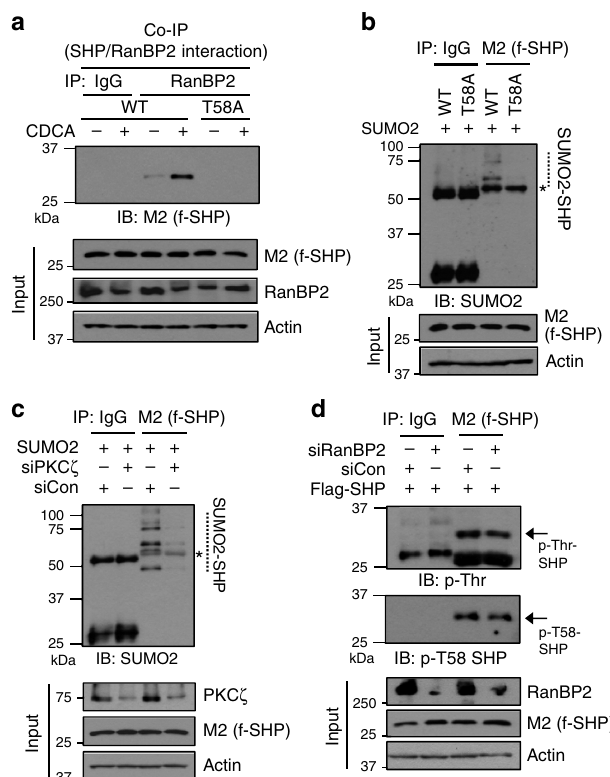
Figure 5 | Phosphorylation of SHP at Thr-58 is likely important for RanBP2-mediated SUMOylation of SHP. HepG2 cells were transfected with expression plasmids or siRNA for RanBP2 or PKC z as indicated, and then, the cells were treated with 50 m M CDCA for 15min. ( a ) SHP interaction with RanBP2 was detected by CoIP. ( b – d ) Phosphorylated mouse SHP at T58 (T55 in human SHP) or SUMOylated SHP at K68 was detected by the IP/IB method or phosphorylated SHP at T58 was detected by IB using the P-T58 SHP antibody. Protein levels in input samples were detected by